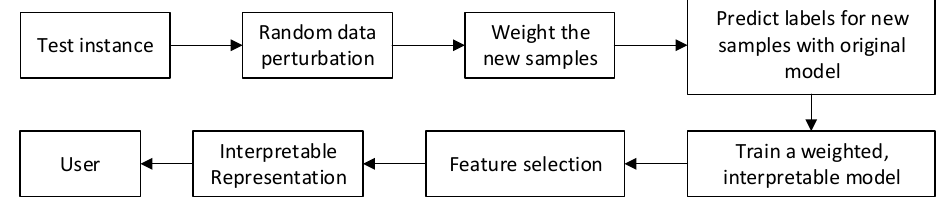
Figure 1. A block diagram of the LIME framework.